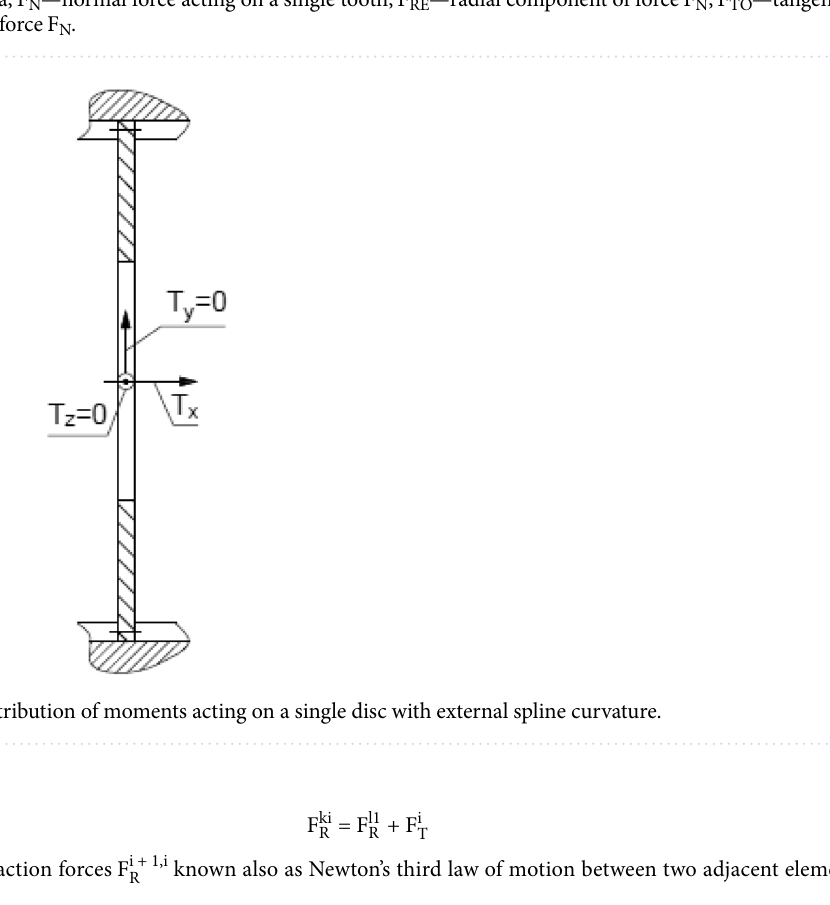
Figure 3. Physical model: ( a ) for three specified plates, ( b ) forces distribution in spline’s teeth: F a —applied axial i + 1,i force to clutch package, F R